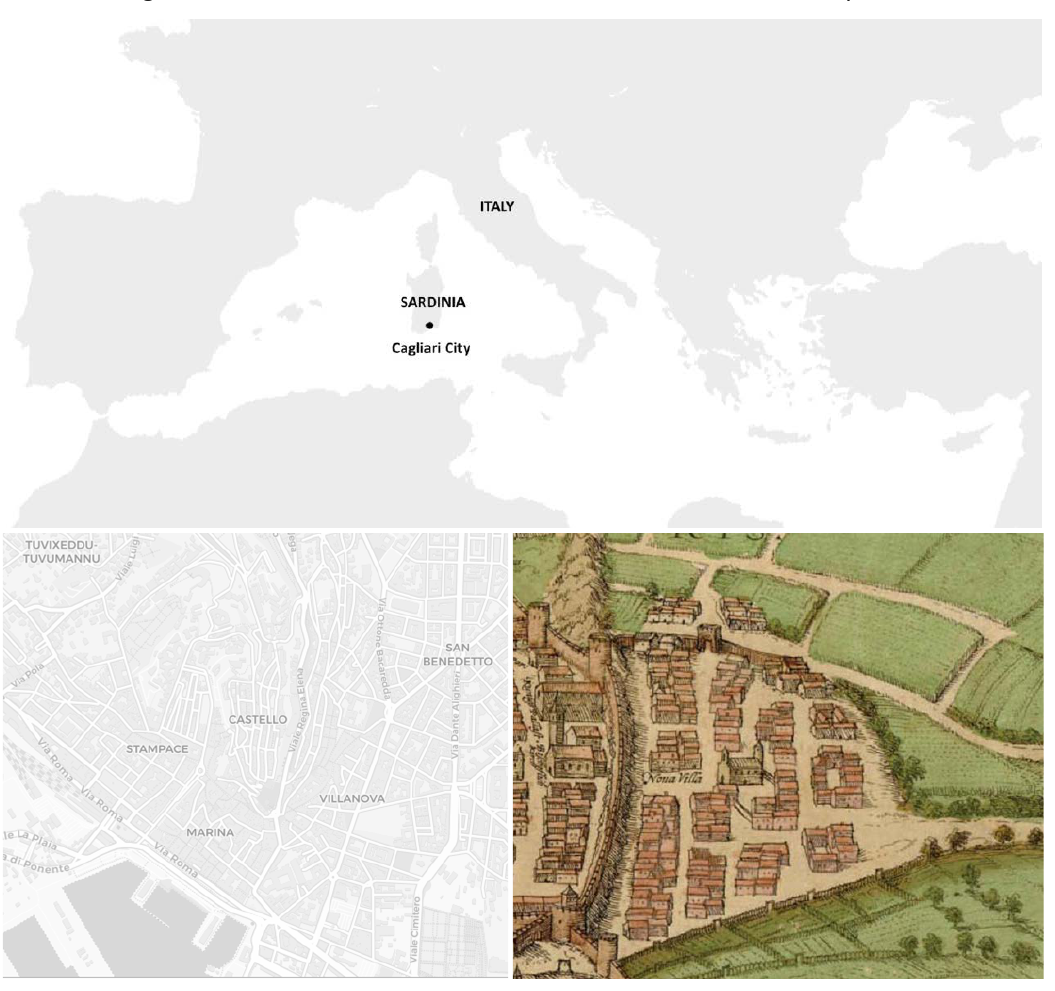
Figure 1: Cagliari City - the geographical context, a view of the city centre and a view of Villanova District in the Cosmographia Universalis by Sebastian Münster (1550) Source: Elaboration by the author on Cagliari City WebGIS and Detailed Plan for its City